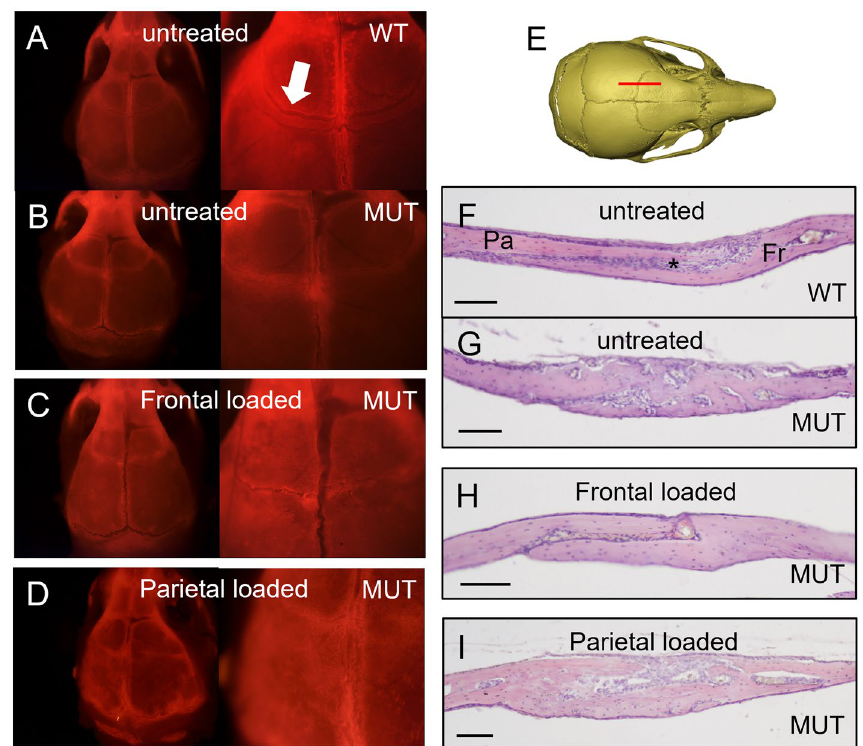
Figure 3. Changes in coronal suture morphology and histology following cranial bone loading. ( A–D ) Calvaria showing fluorescent Alizarin complexone staining at 0.8 × (left) and 2 × (right) magnification. ( A ) Wild-type (WT) calvaria show the typical overlapping bone structure of the coronal suture (arrow). ( B ) Mutant (MUT) coronal sutures show some staining indicating active bone growth but the overlapping structure is absent. ( C ) Frontal loaded calvaria show a patent suture, but with a reduced area of frontal-parietal overlap. ( D ) Parietal loaded calvaria show no difference from untreated mutant sutures. ( E ) Sagittal sections through the coronal suture (red line) at P21 were stained with H&E. ( F ) Wild-type (WT) sutures show a characteristic overlapping feature of the parietal (P) and frontal (F) bones with the suture mesenchyme (*) in between. ( G ) Mutant (MUT) sutures show a loss of patency phenotype with fusion between parietal and frontal bones and loss of mesenchyme. The suture appears thickened as compared to flanking bone. ( H ) Animals treated with frontal bone loading show a more normal suture with bones appearing unfused, but with significant loss of mesenchyme. ( I ) Animals treated with parietal bone loading show no improvement and look similar to untreated sutures. Scale bars are 100